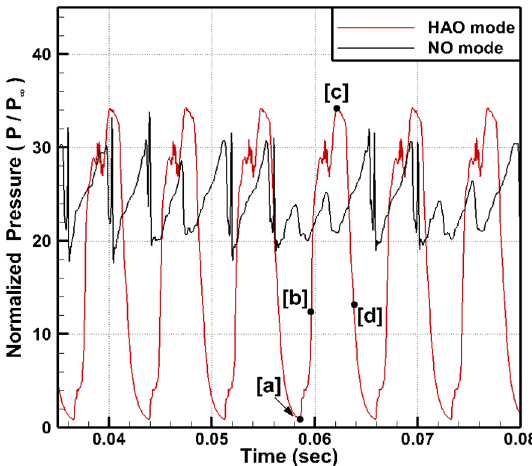
Figure 10. Time histories of the normalized pressure at x/h = 12.21 in HAO mode and NO